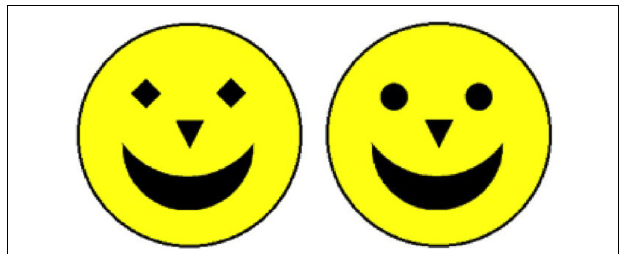
FIGURE 1 | An example of a test trial in the Featural condition. The stimulus on the left is an example of a featurally-changed face, while the stimulus on the right is the familiarized face.